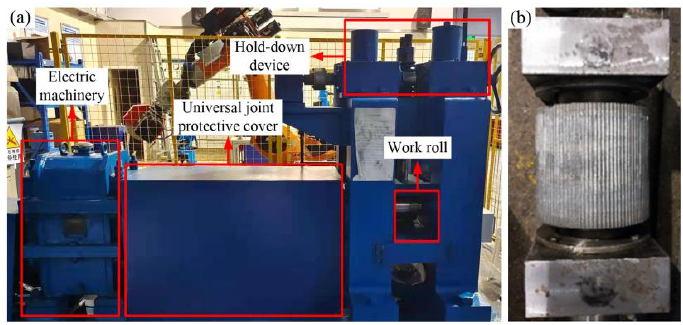
Figure 2. Experimental equipment: ( a ) two-high mill; ( b ) corrugated roll.